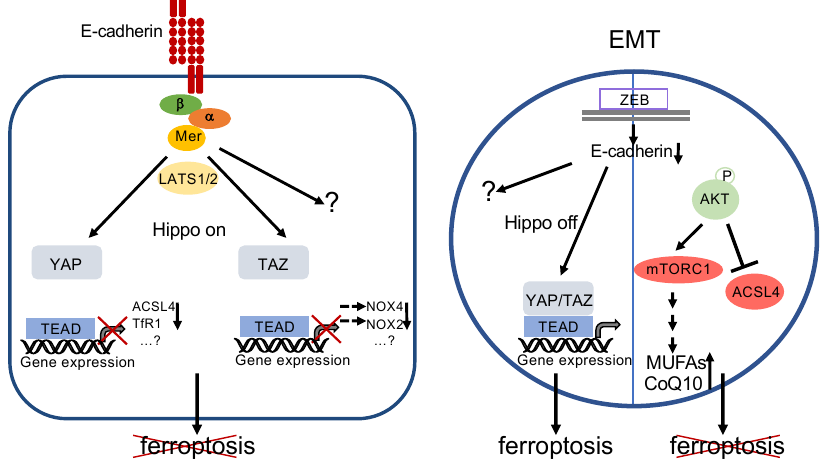
Figure 6. Regulation of ferroptosis by E-cadherin and EMT. Left: E-cadherin activates the Hippo pathway, thereby inactivating YAP- and TAZ-activity. This leads directly or indirectly to decreased expression of proteins that are relevant for ferroptosis (note that decreased levels of NOX4 and NOX2 are due to reduced expression of EMP1 and ANGPTL4 , respectively, see text for details). How- ever, involvement of additional genes and/or signalling pathways is likely. Ferroptosis is blocked. Right: EMT—for instance, triggered by activation of ZEB—leads to a loss of E-cadherin expression and inhibition of the Hippo pathway. Although the downstream targets have not been elucidated so far, YAP/TAZ activation supports ferroptosis. Additional pathways remain to be elucidated. However, this can be counterbalanced by phosphorylation of AKT (or, possibly, other mechanisms). Activated AKT may lead to a decreased level of ACSL4 as well as increased formation of MUFAs and CoQ10 via mTORC1 stimulation. Ferroptosis is